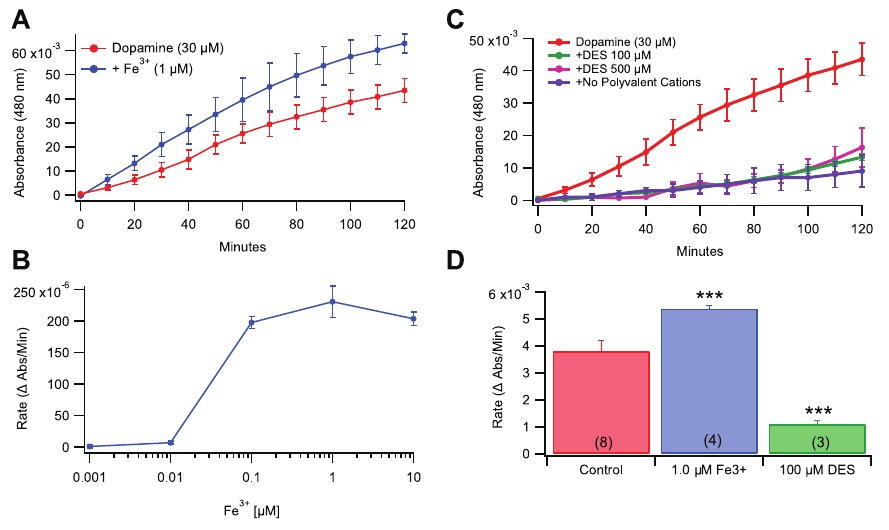
Figure 2. E ff ects of Fe 3 + levels on DA melanogenesis. ( A ) Fe 3 + increased the DA melanogenesis in a concentration-dependent manner in transferrin-treated, iron-free water, as untreated ECF has a trace of Fe 3 + . ( B ) Dose-response curve for growth rates of DA melanogenesis based on Fe 3 + concentration. The curve is roughly sigmoidal with a precipitous rise between 0.01 and 0.1 µ M and with an EC 50 of ~0.03 µ M Fe 3 + . ( C ) Comparison of DA melanogenesis rates of 1.0 µ M Fe 3 + and 30 µ M DA (Control) vs. 100 µ M and 500 µ M DES (iron chelator) vs. no polyvalent cations. ( D ) Fe 3 + significantly increased the rate of melanogenesis while DES decreased it. Values in parentheses represent n values. Asterisks *** indicate significance level p < 0.001. Data is presented as mean ±